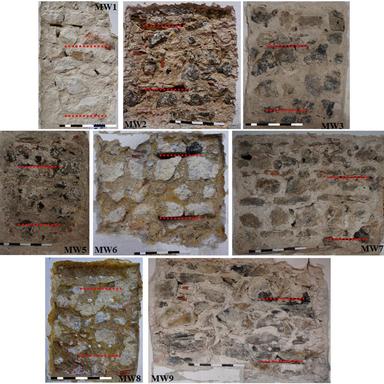
Visual appearance of the masonry panels exposed by the removal of plaster/render and position of the flat jacks (red dashed lines) – Total length of scale: 50 cm (5 and 10 cm segments). (For interpretation of the references to color in this figure legend, the reader is referred to the web version of this article.)